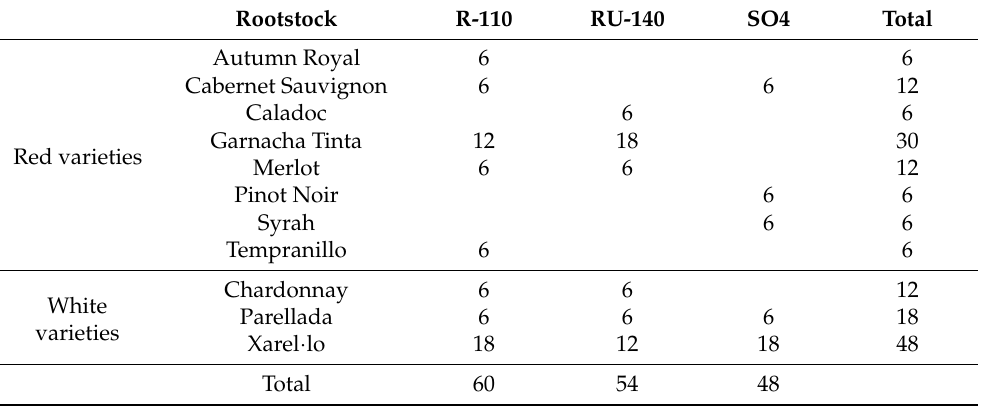
Table 1. Study design showing the number of plants in each scion rootstock combination. Grafted plants were obtained from four different nurseries overall. At least two nurseries per color rootstock combination were included in replicates of six (i.e., three plants each of control and hot water treatment). Rootstocks shown are 110 Richter (R-110), 140 Ruggeri (RU-140), or Selection Oppenheim 4 (SO4). Rootstock R-110 RU-140 SO4 Total Autumn Royal 6 6 Cabernet Sauvignon 6 6 Caladoc Garnacha Tinta Red varieties Merlot Pinot Noir Syrah Tempranillo Chardonnay 6 White